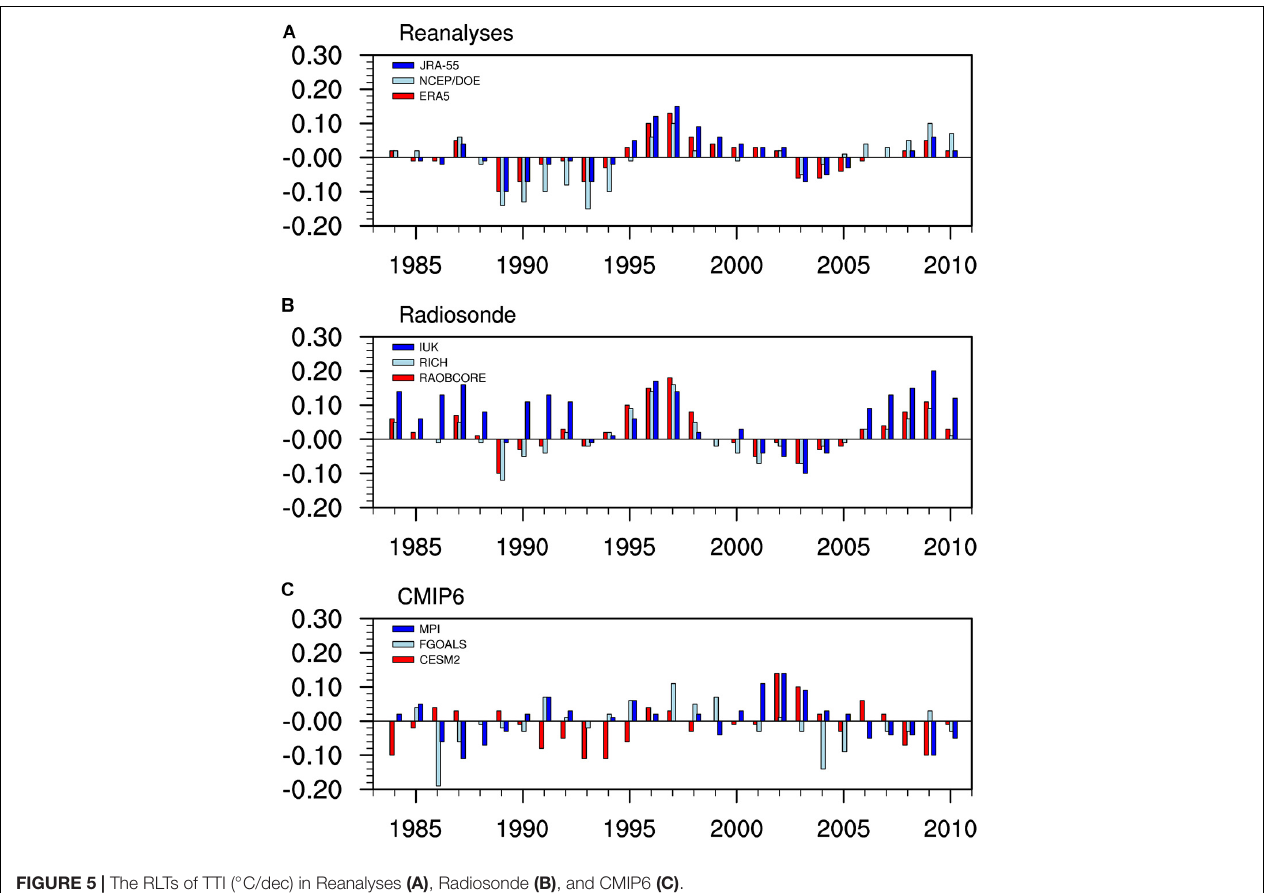
FIGURE 5 | The RLTs of TTI ( ◦ C/dec) in Reanalyses (A) , Radiosonde (B) , and CMIP6 (C) . TABLE 4 | Correlation of the RLTs of TTI between reanalysis data and radiosonde data the SASMIs (bold indicate a correlation coefficient above 0.37, representing a significance test at the 95% confidence level). IUK RICH RAOBCORE JRA-55 NCEP/DOE ERA5 MI-1